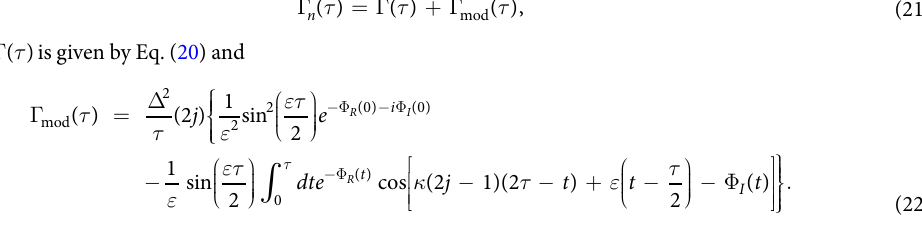
. The major difference